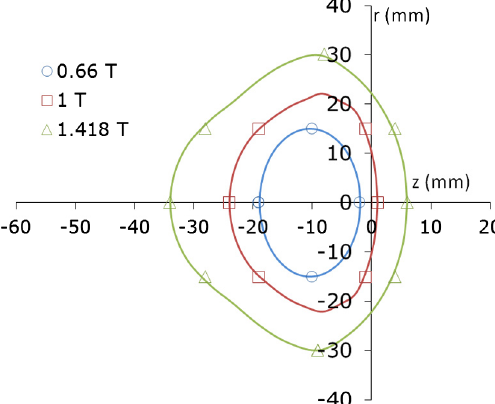
FIG. 30. Magnetic field map for 15 kA current intensity on the coils.